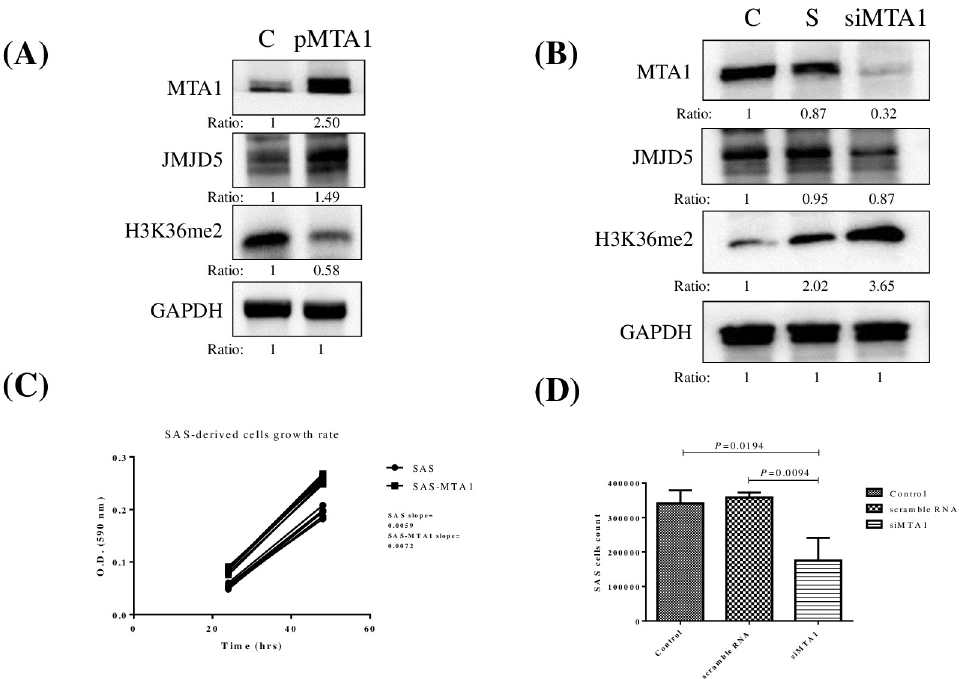
Fig 3. MTA1 overexpression induced JMJD5 expression and cell proliferation in oral cancer. (A) Constructs expressing MTA1 were developed and transfected into SAS cells. C as the parental SAS cells without transfected MTA1 expressed vector. pMTA1 as transfected overexpressed MTA1 vector. Overexpressed MTA1 upregulated JMJD5 and downregulated H3K36me2. (B) MTA1 knockdown downregulated JMJD5 and upregulated H3K36me2. The ratio was assessed as the ratio of densities of corresponding protein bands and quantification with Image J software. (C) Overexpressed MTA1 promoted the growth of oral cancer SAS cells. (D) Repression of MTA1 using siRNA suppressed SAS cell proliferation. S as the scramble RNA. The concentration of S and siMTA1 are 20 μ M.